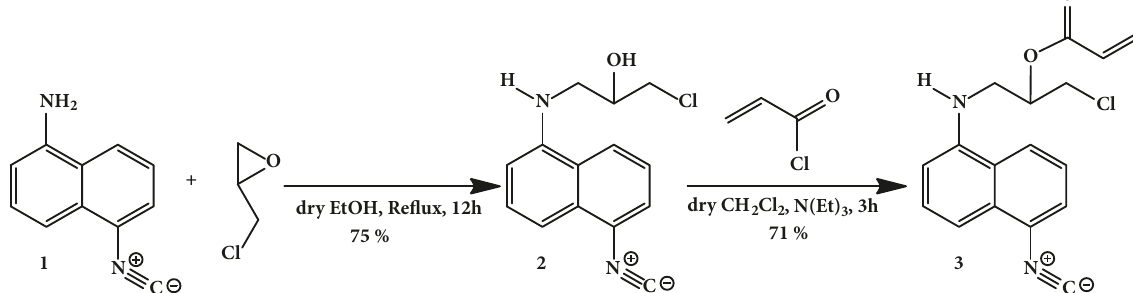
Figure 2: Synthesis of 1-(3-chloro-2-hydroxyprop-1-yl)-amino-5-isocyanonaphthalene (2, CHAIN) and 1-(2-acryloyloxy-3-chloro-prop-1- yl)-amino-5-isocyanonaphthalene (3, ACAIN).